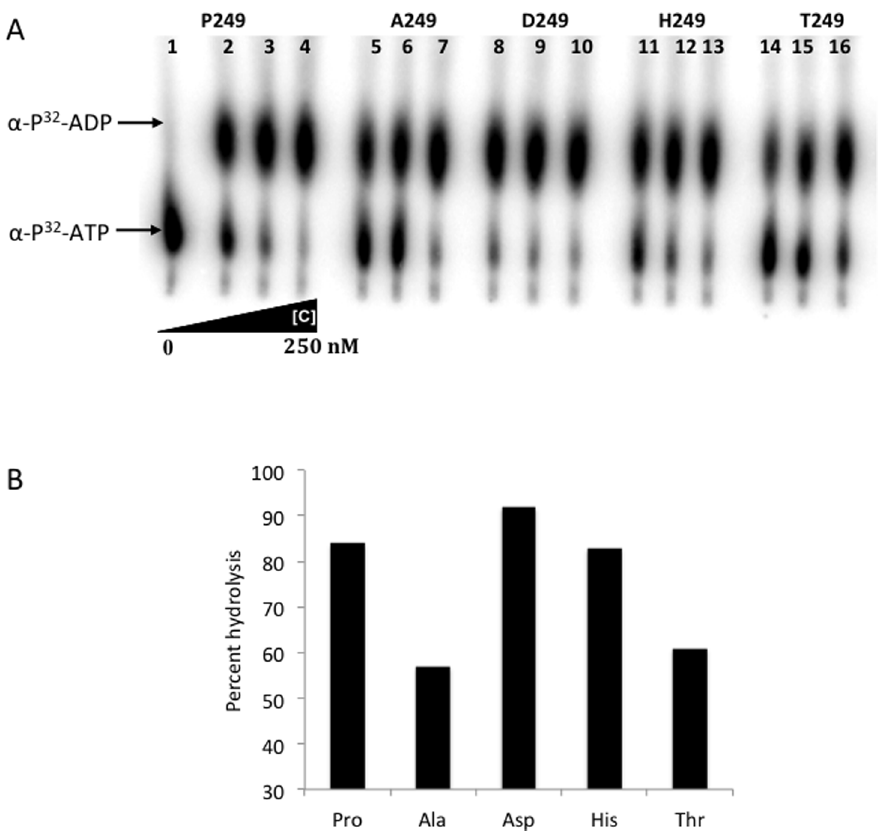
Figure 9. NS3-249 point mutant ATPase kinetics during dsRNA unwinding. (A) ATPase activity with different concentration of NS3 protein. Lane 1: no protein, with 62.5 nM of recombinant protein (lane 2, 5, 8, 11 and 14), 125 nM of protein (3, 6, 9, 12 and 15), and 250 nM of protein (lane 4, 7, 10, 13 and 16). (B) Percent ATP hydrolyzed by each NS3-249 helicase protein at concentrations of 125 nM.